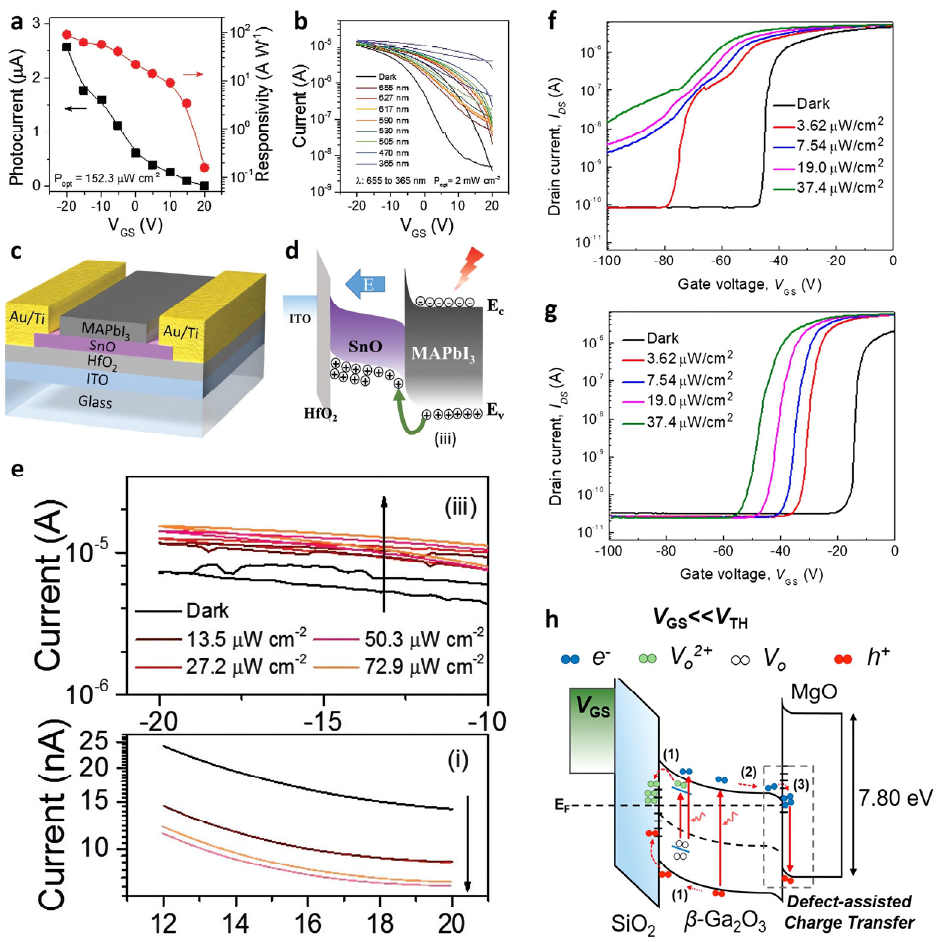
Figure 6. Oxide-based photodetector. ( a ) Plots of I Ph and R as a function of V G at the light intensity. ( b ) Transfer curves of the phototransistor with different wavelengths of light illumination. ( c ) Schematic diagram of the SnO phototransistor. ( d ) Schematic diagram of the charge transport mechanism in the SnO/perovskite interface under light irradiation, corresponding to the upper panel of Figure 5e. ( e ) Magnified transfer characteristics of the perovskite/SnO phototransistor at specific V G . Transfer characteristics of the ( f ) β -Ga 2 O 3 and ( g ) β -Ga 2 O 3 /MgO heterostructure-based phototransistors. A light-induced hump appeared in the β -Ga 2 O 3 phototransistor when the V G was lower than V Th . ( h ) Schematic energy band and carrier transport at the β -Ga 2 O 3 /MgO device when the V G was less than V Th . ( a – e ) Reproduced with permission from [127]. Copyright Wiley, 2019. ( f – h ) Reproduced with permission from [130]. Copyright American Chemical Society, 2021.